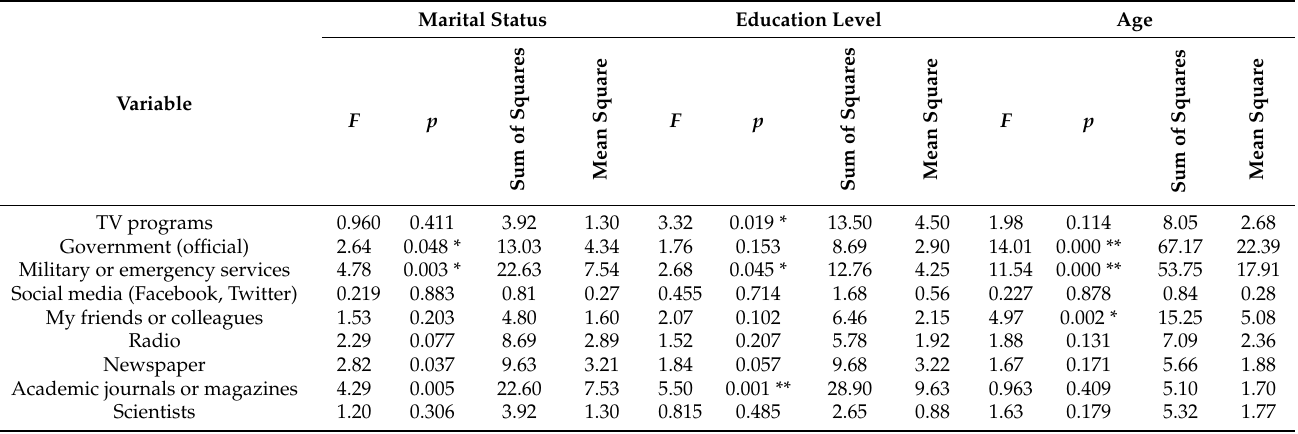
Table 6. One-way ANOVA results comparing sources citizens use to receive information about COVID-19 by marital status, education level, and